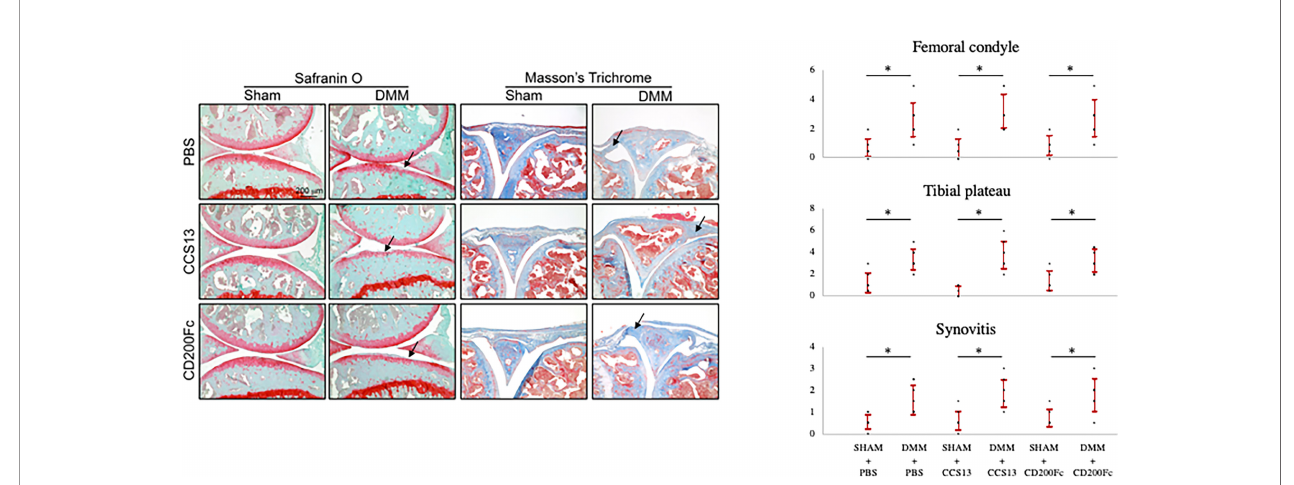
FIGURE 3 | Histology images and scores of representative stained knee sections. 1 The extent of cartilage loss in the femoral condyle and tibial plateau was scored separately using the OARSI scoring system: 0 [normal] to 6[erosion>75% of articular surface]. Synovitis was scored from 0 (normal) to 3 (severe). Safranin O-stained sections were used to score cartilage degeneration and Masson ’ s trichrome-stained sections were used to measure synovitis. Black arrows indicate areas of cartilage degeneration and synovitis in Safranin O or Masson ’ s Trichome-stained sections respectively. 2 Dots represent individual data points and error bar represents standard deviation. 3 Statistical analysis was conducted using one-way analysis of variance test to compare the six groups. *p <